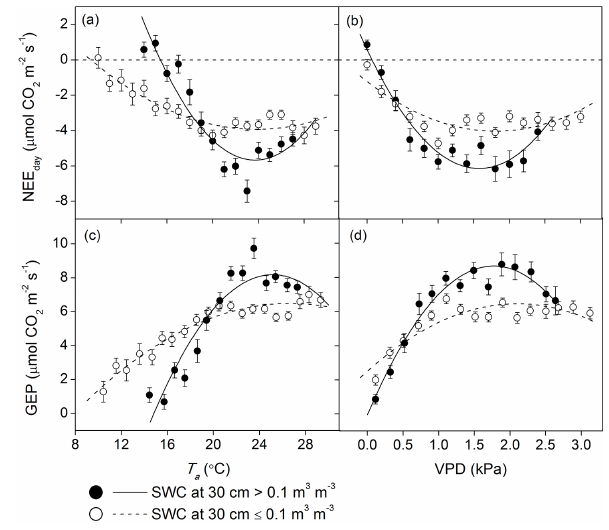
Figure 4. Responses of daytime net ecosystem CO 2 exchange (NEE day ) and gross ecosystem productivity (GEP) to air temper- ature (T a ) and vapor pressure deficit (VPD) under different soil water contents (SWC) measured at 30cm depth. Only data from the peak growing season (June–August) were used to minimize the confounding effects of phenology. Half-hourly NEE day was bin- averaged into 1 ◦ C T s ( a and c ) and 0.2kPaVPD ( b and d ) inter- vals, respectively. Bars indicate standard errors. Response curves were fit using the quadratic model. The horizontal dashed lines in (a) and (b) represent y =